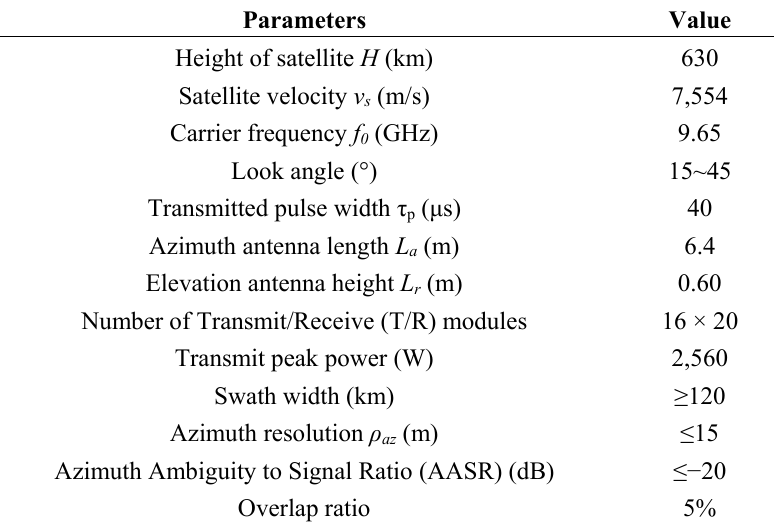
Table 1. Simulation